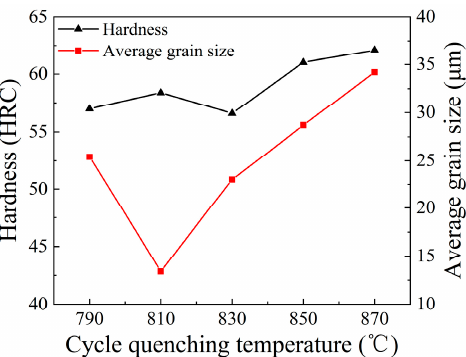
Figure 12. Relationship among hardness, average grain size and cyclic quenching temperature . Similarly, under the cyclic quenching times of one, two, three and four times, the hardness values of the specimens were measured as 58.4 HRC, 60.7 HRC, 61.1 HRC, 62.7 HRC, respectively. The relationship among average grain size, hardness and cyclic quenching times is demonstrated in Figure 13. It can be seen, from Figure 13, that, with the increase in cycle quenching times, the hardness increased continuously with the de- crease in average grain size. This is mainly due to the fact that, at the same optimal cyclic quenching temperature, grain refinement was prominently increased with the increase in cyclic quenching times.